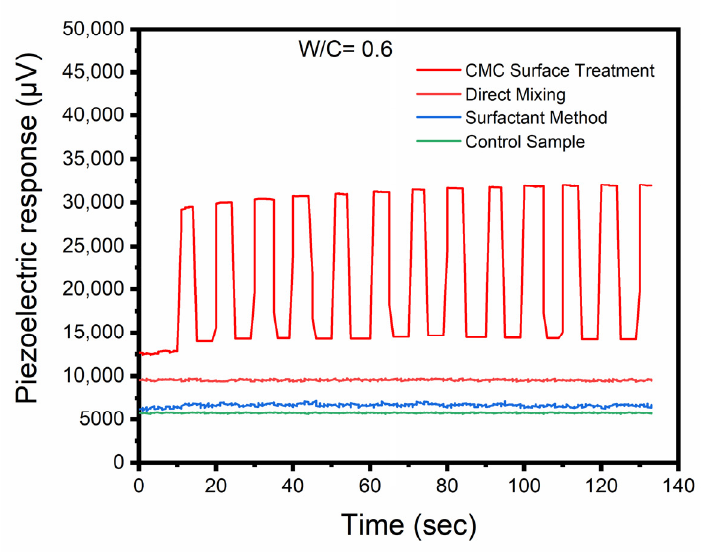
Figure 7. Comparisons of piezoelectric responses among the three dispersion methods with a constant W/C ratio of 0.6.